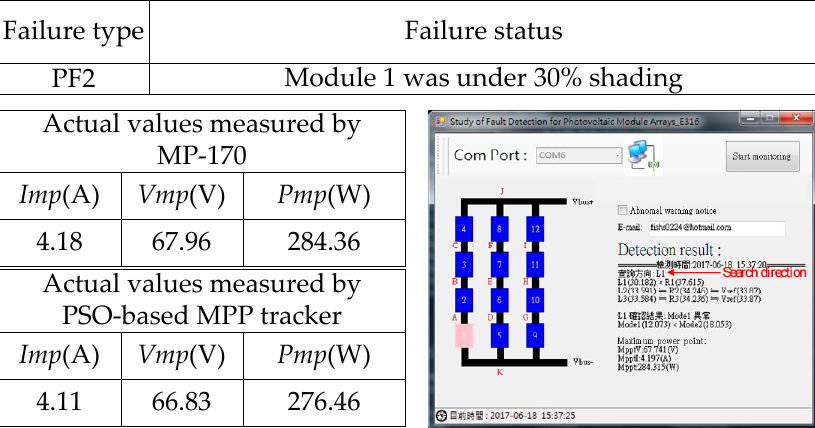
Figure 16. Experimental outcome for failure type PF1.